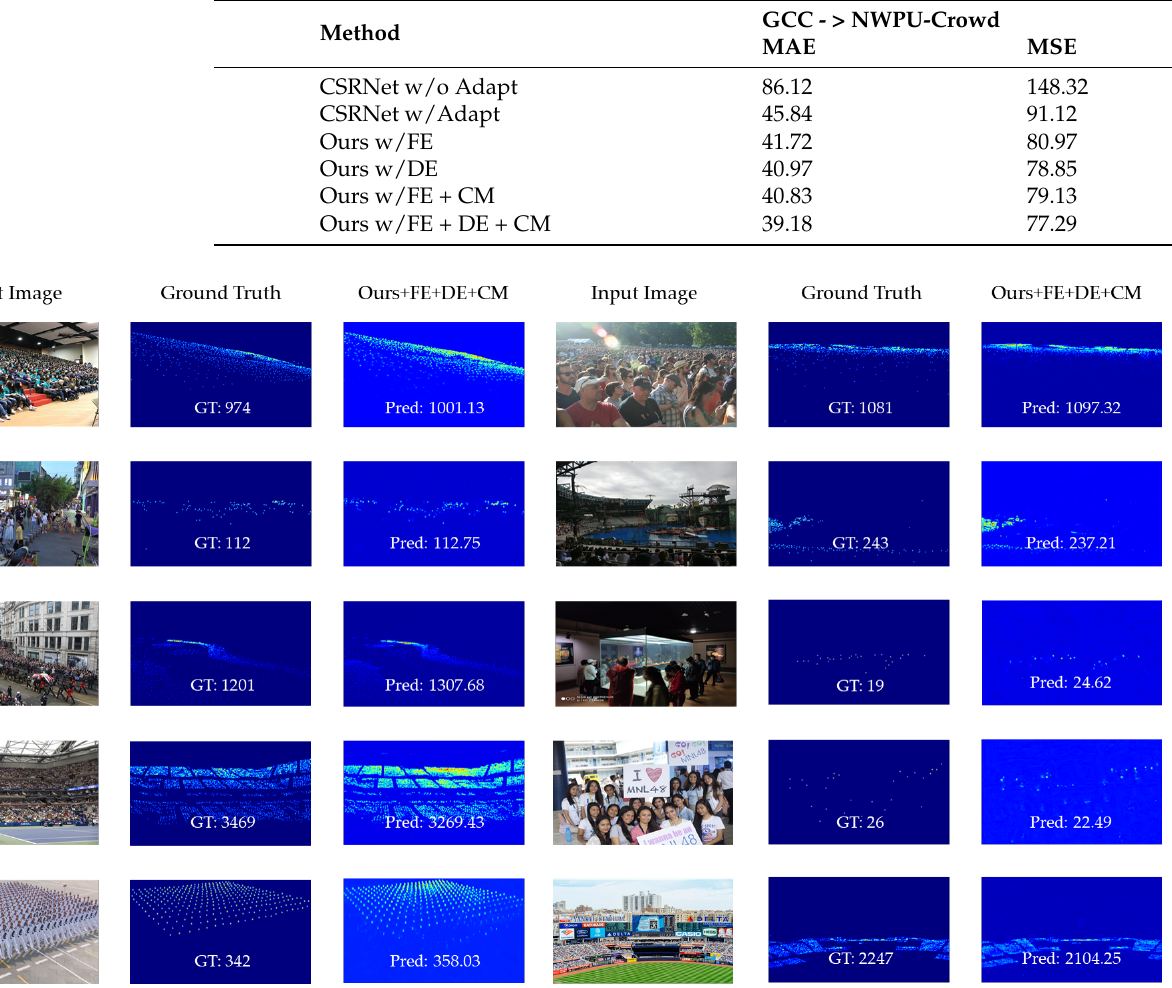
Table 3. Ablation Study: The performance of baseline with and without adaptation and our approach in cross-domain scenarios.